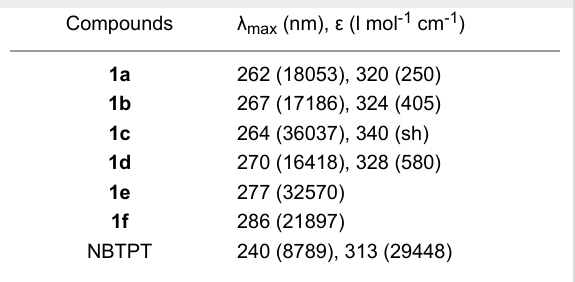
Table 2: UV absorption λ max and molar extinction coefficients (ε)of 1a-f and NBTPT in CH 2 Cl 2